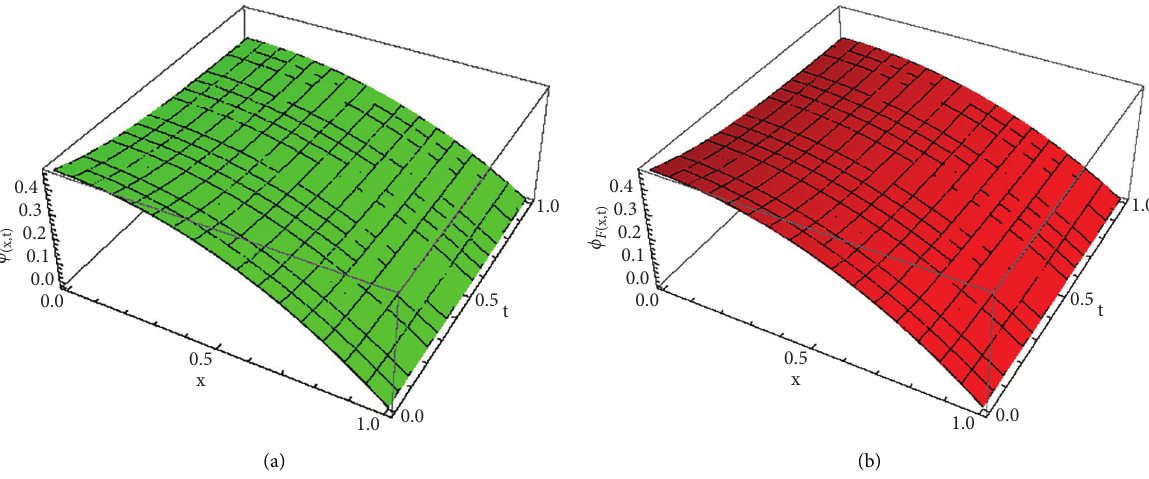
Figure 5: 3D plot of the approximate and exact solutions at F � 5 via μ � 2 ( a ) and μ � 1 . 9 ( b ) .